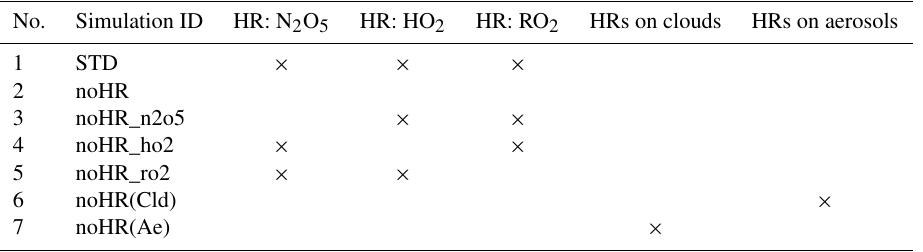
Table 3. Main sensitivity simulations for HRs in this